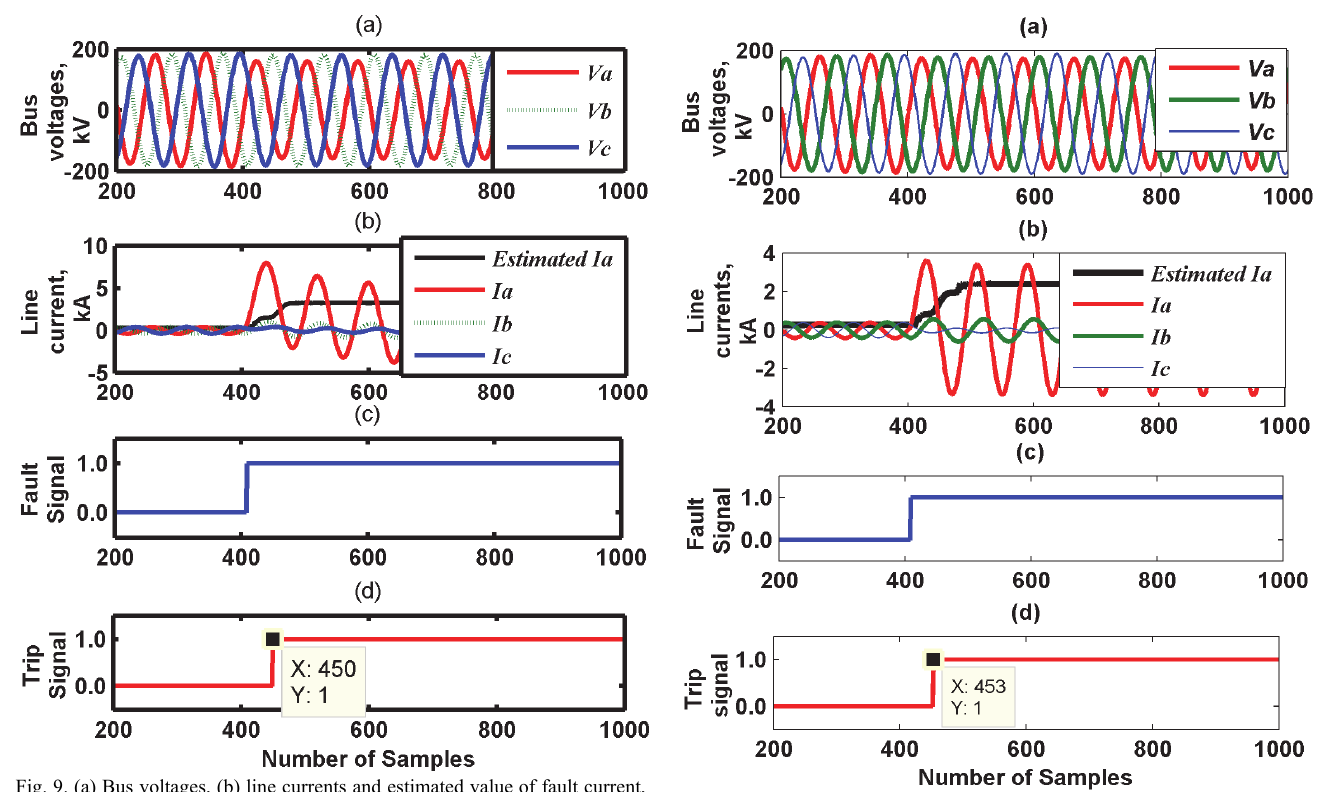
Fig. 8. Fault impedance trajectory during (a) Case 1, (b) Case 3, (c) Case 17, (d) Case 18, (e) Case 26, (f) Case 27 of Table I.